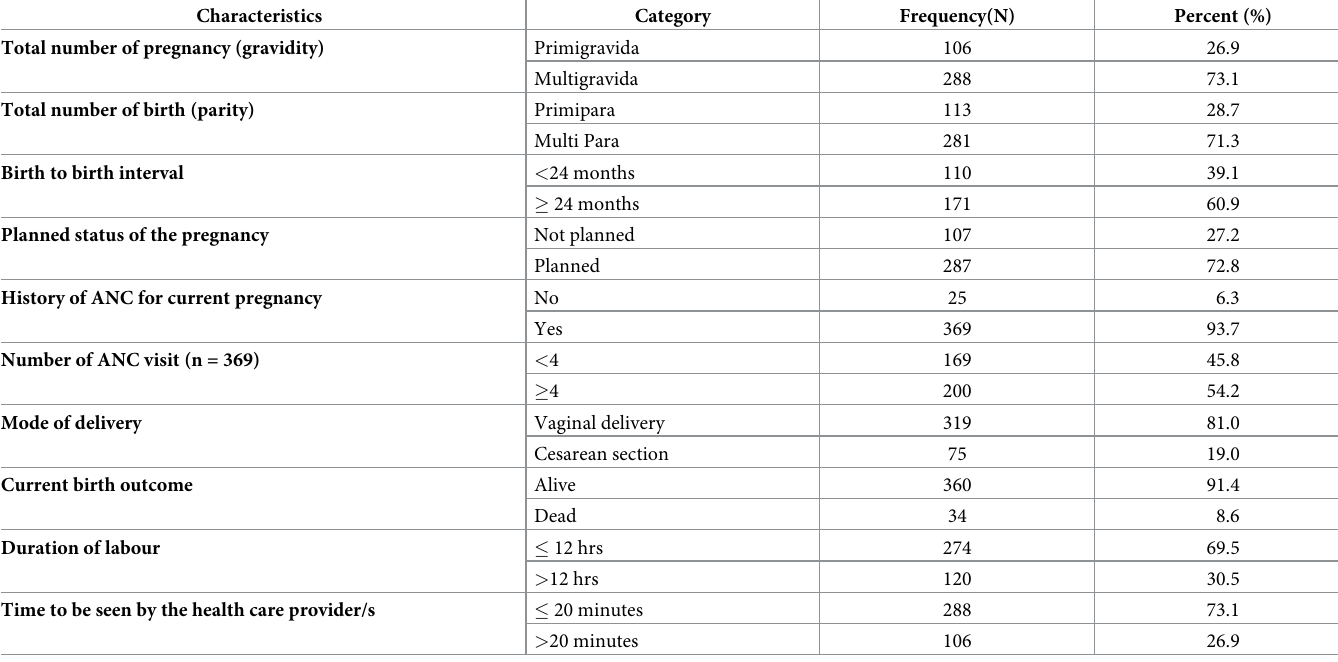
Table 2. Obstetrics and maternal health services characteristics among postpartum women at public hospitals of North Shoa Zone Ethiopia (n = 394).